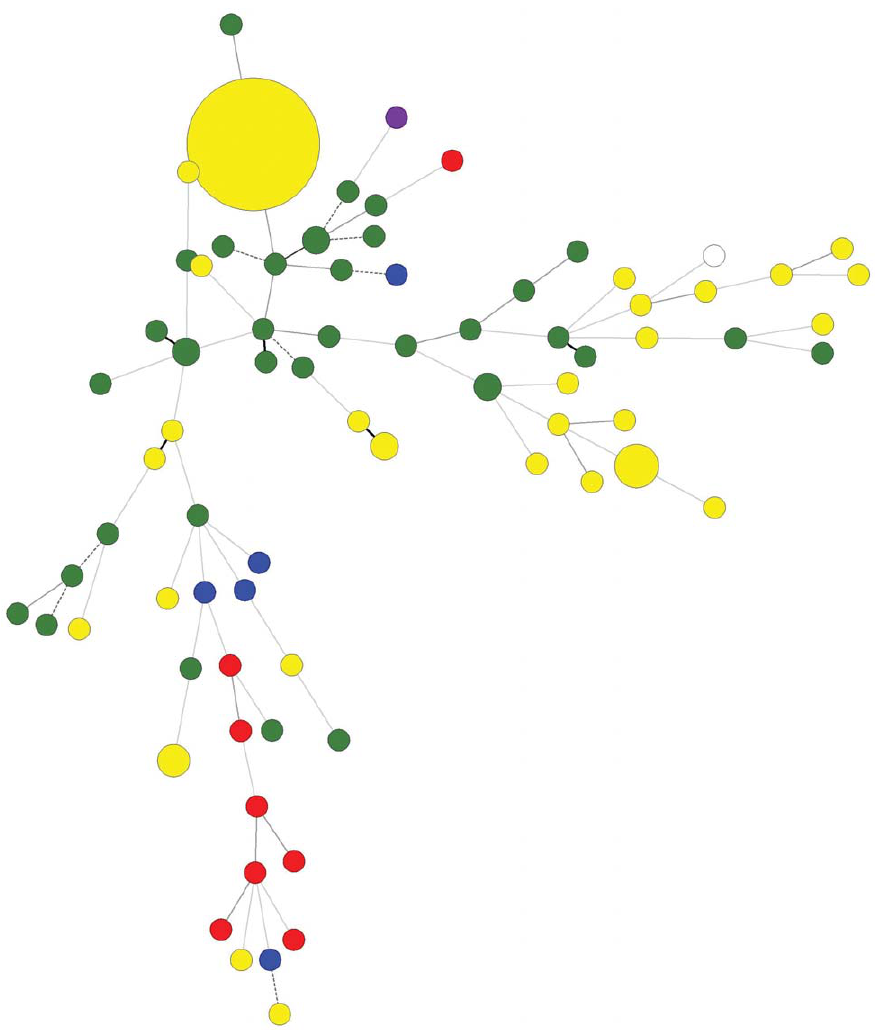
Figure 3. Minimum spanning tree showing wide genotypic diversity in the TR 34 /L98H and wild type A.fumigatus isolates studied. The figure shows the 74 different genotypes (circles), the number of strains belonging to the same genotype (sizes of the circles), and origin of isolates (circles in yellow indicate Indian isolates; green Dutch isolates; red Chinese isolates; blue French isolates, purple German isolate and white reference strain, AF293). Solid thick and thin branches indicates 1 or 2 microsatellite markers differences, respectively; dashed branches indicates 3 microsatellite markers difference between two genotypes; 4 or more microsatellite markers differences between genotypes are indicated with dotted branches.